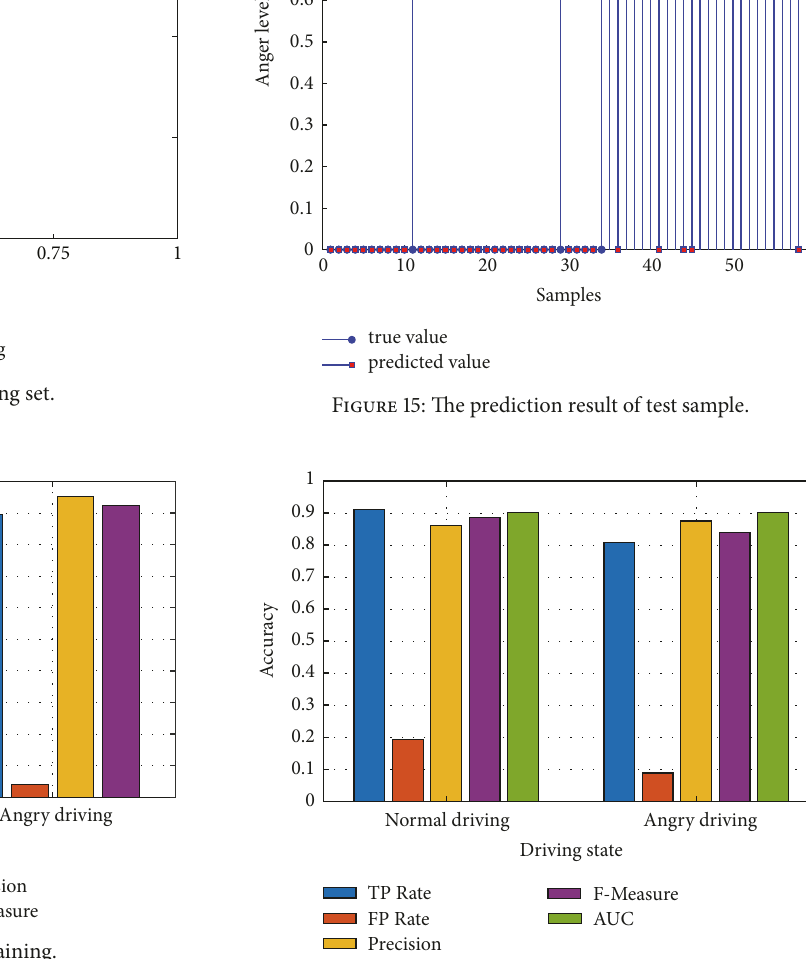
Figure 16: The accuracy of